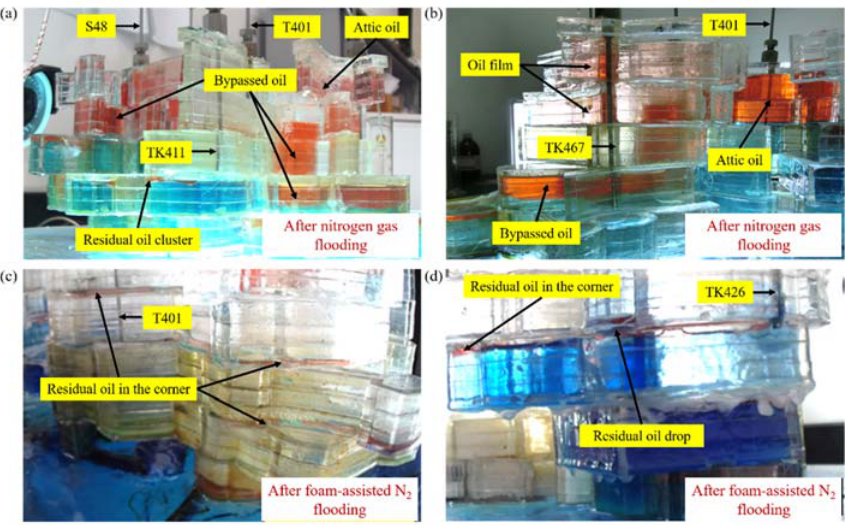
Figure 11. Residual oil types in three-dimensional visualized fracture–vuggy physical model: ( a , b ): after nitrogen gas flooding and ( c , d ): after foam-assisted N 2 flooding.